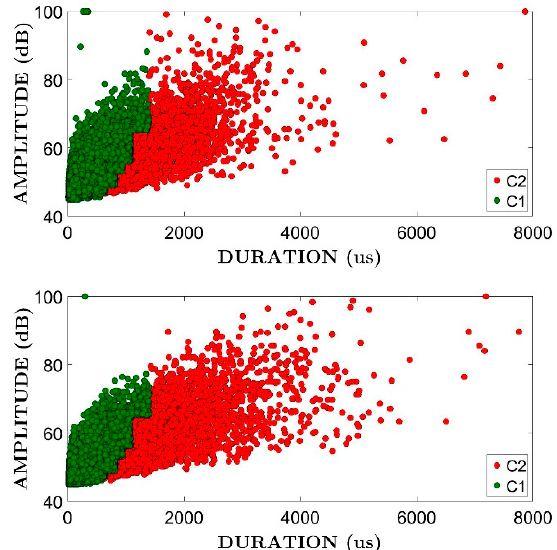
Figure 8. Amplitude-Duration plots for AE signals. Zone solid head of the exterior connection (ESH) of specimens BS1 ( top ) and BS2 ( bottom ). Green: passing the Swansong filter: Red: No passing the Swansong filter.